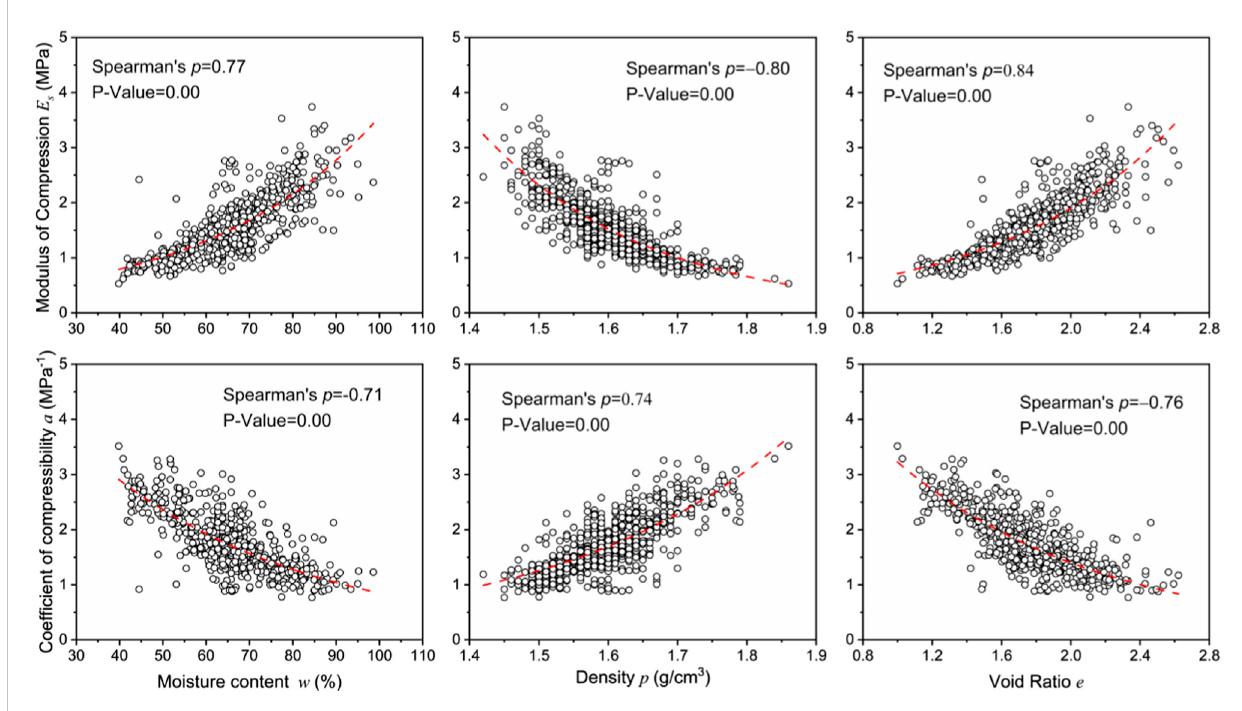
FIGURE 5 Plots of compression indices versus physical parameters in the CP test